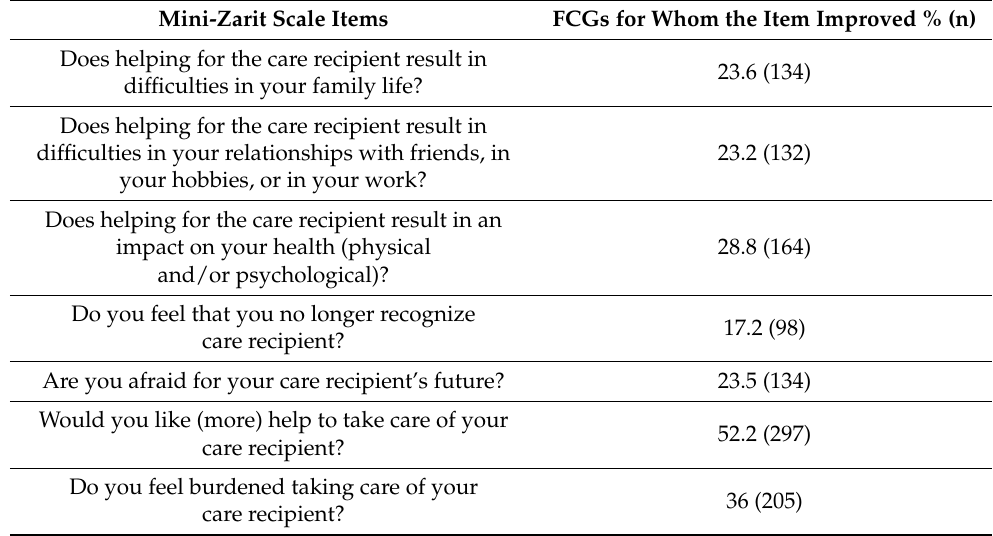
Table 3. Improvement of each items score of Mini-Zarit Scale post-3S.